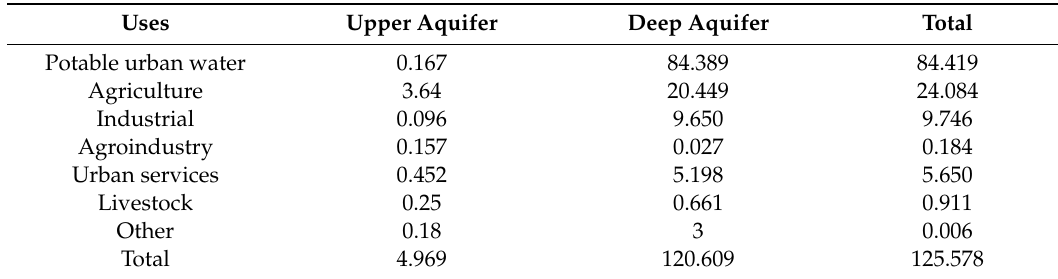
Table 1. Groundwater extraction (Mm 3 / year).